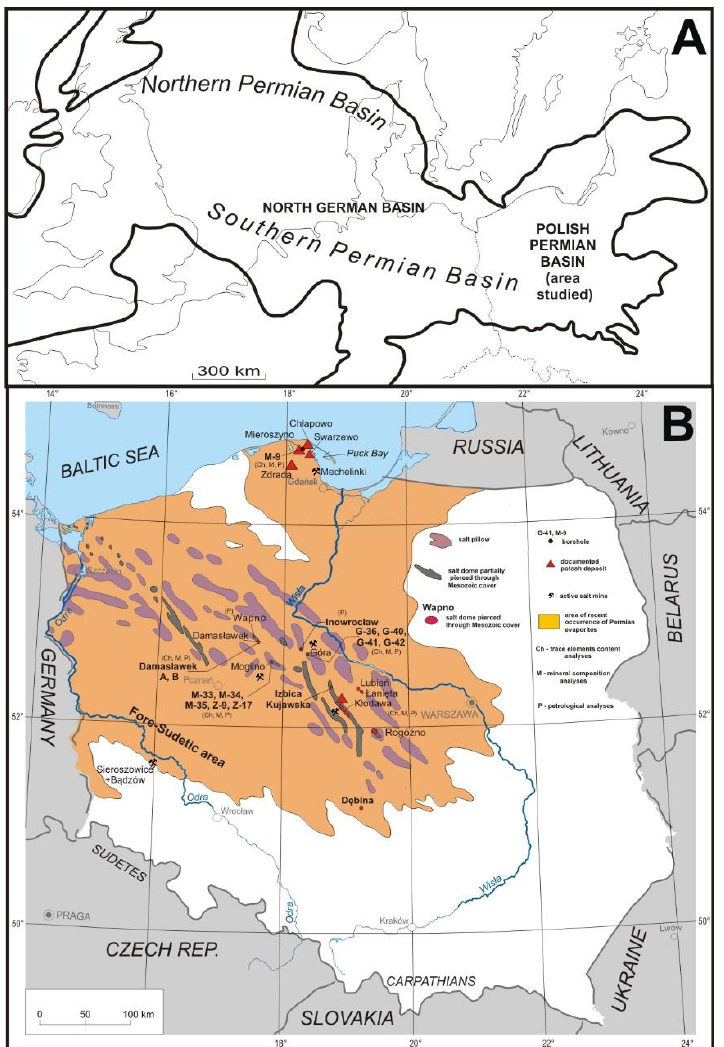
Figure 1. Studied Zechstein potash-bearing deposits in Poland. ( A ) Extent of the European Permian Basin with the area studied (after [56]). ( B ) Sites of analysed potash-bearing